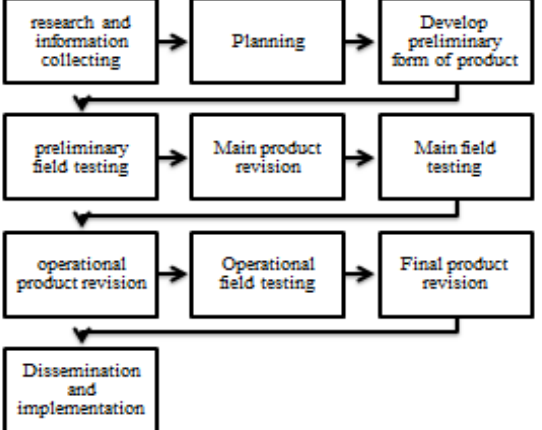
Figure 1. The procedure of research and development (Borg &